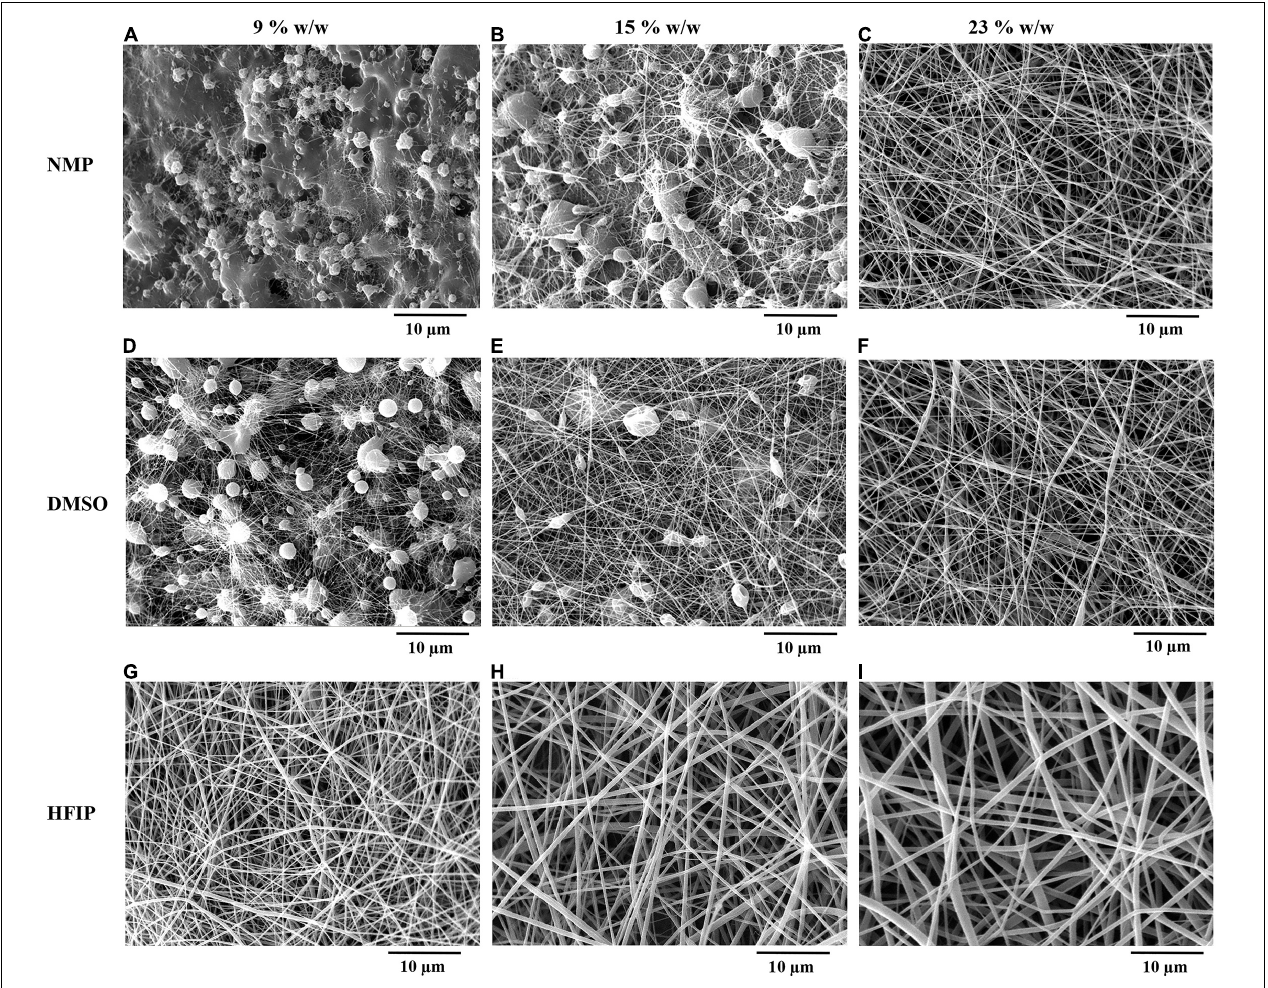
FIGURE 1 | Morphology of electrospun PPC nanofibers prepared with NMP (A–C) , DMSO (D–F) , and HFIP (G–I) in different concentrations of PES [9% w/w (A,D,G) , 15% w/w (B,E,H) , 23% w/w (C,F,I) ], (PANI concentration: 0.5%